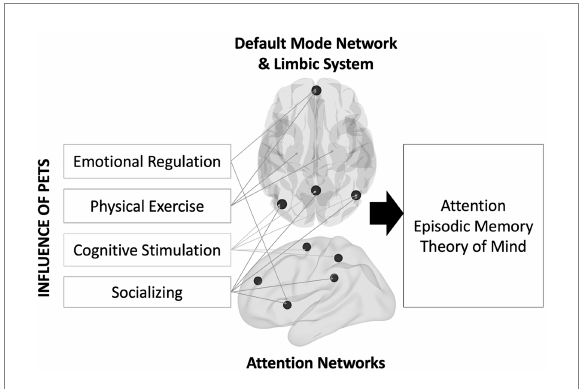
FIGURE 1 Theoretical model describing the influence of pet ownership on brain and cognitive